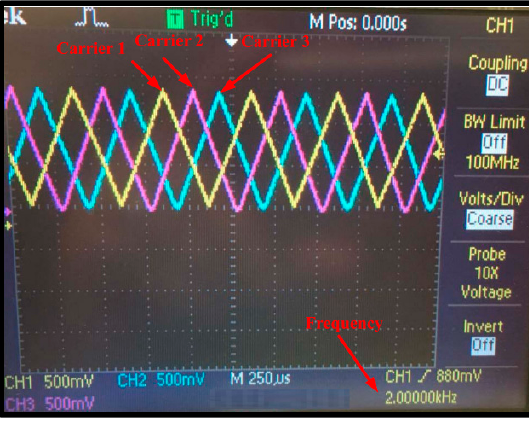
Figure 20. Three converter carriers after ASA.